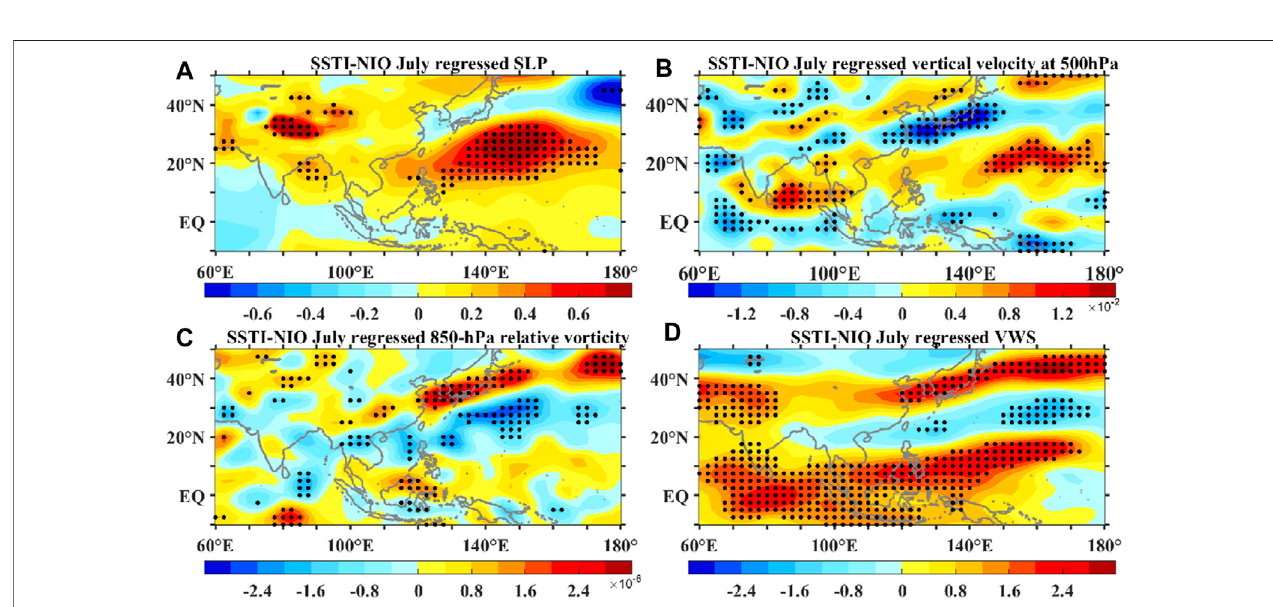
FIGURE 7 | Regression patterns of the July. (A) SLP anomaly (units: hPa), (B) 500-hPa vertical velocity anomaly (units: Pa/s), (C) 850-hPa relative vorticity anomaly (units: 10 – 6 s), and (D) VWS anomaly between 850 and 200 hPa (units: m/s) upon the standardized July SSTI-NIO index during 1980 – 2020. Dotted areas indicate statistical signi fi cance at the 95% level, as estimated by a Student ’ s t -test.